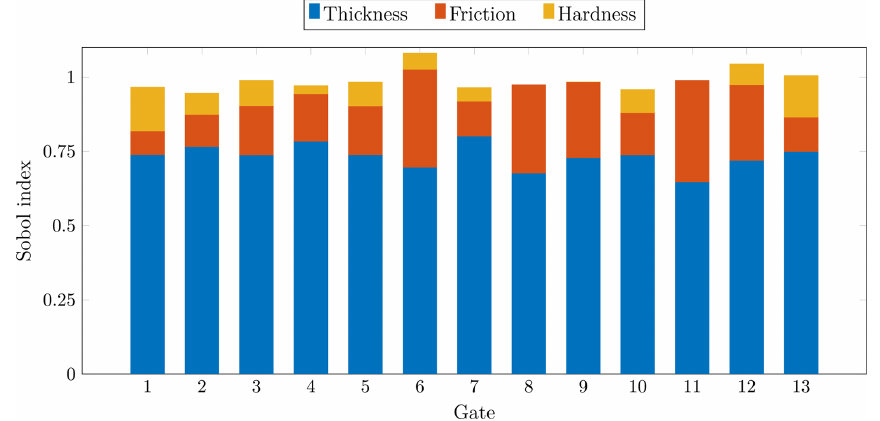
Figure 13. Sobol sensitivity indices for the mass flux across flux gates. The gap between the height of a bar and the unit value represents the interaction index.